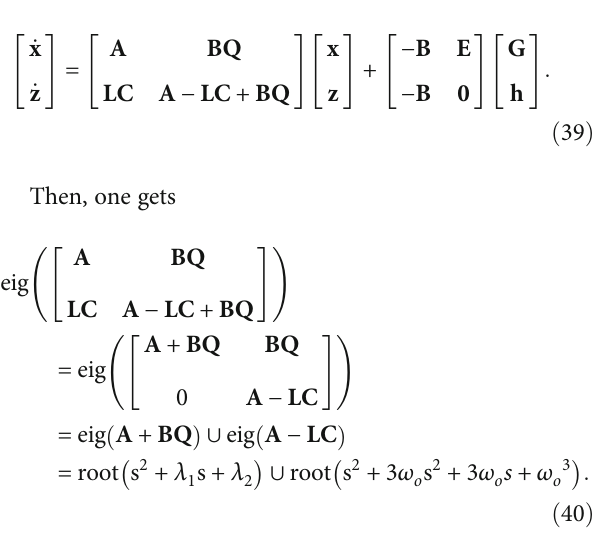
Figure 4: Response of the position loop.